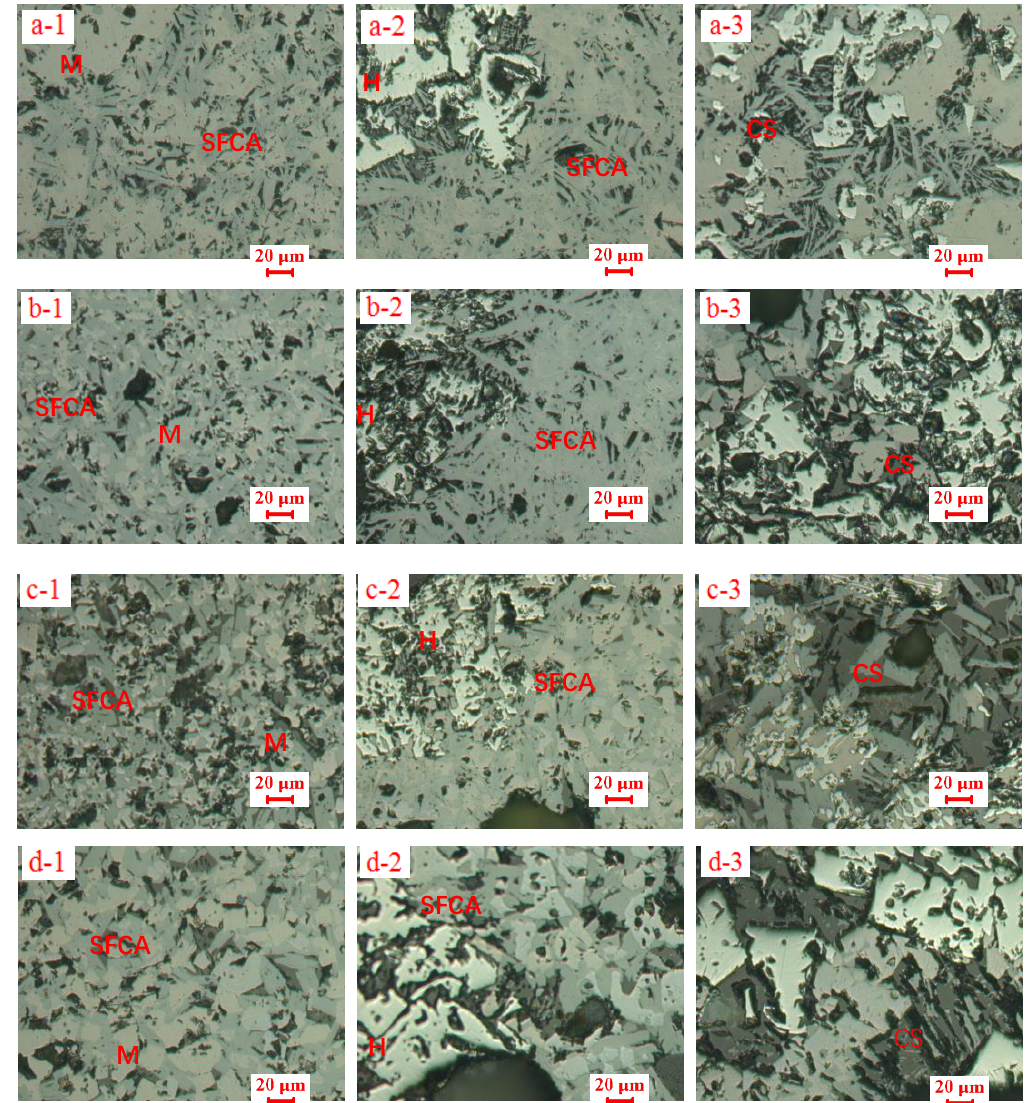
Figure 7. Effects of SiO 2 content on microstructure. (a-1,a-2,a-3) SiO 2 = 4.80%; (b-1,b-2,b-3) SiO 2 =